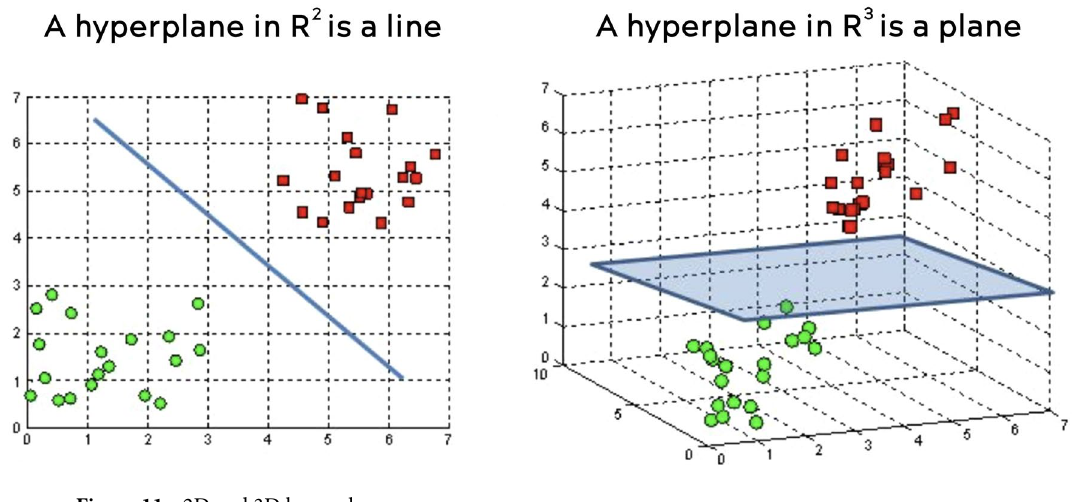
Figure 11. 2D and 3D